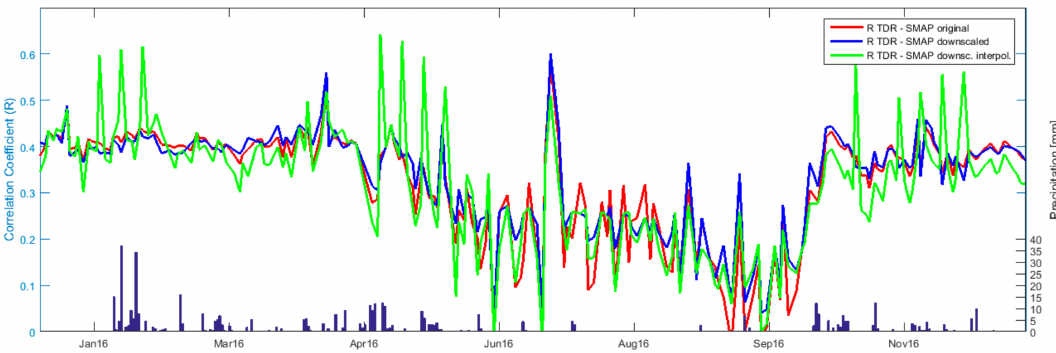
Figure 7. Spatial correlation of SMAP original coarse product, the SMAP downscaled result, and the SMAP interpolated and downscaled result for 2016 with in situ measurements of the REMEDHUS network, and precipitation average for the REMEDHUS